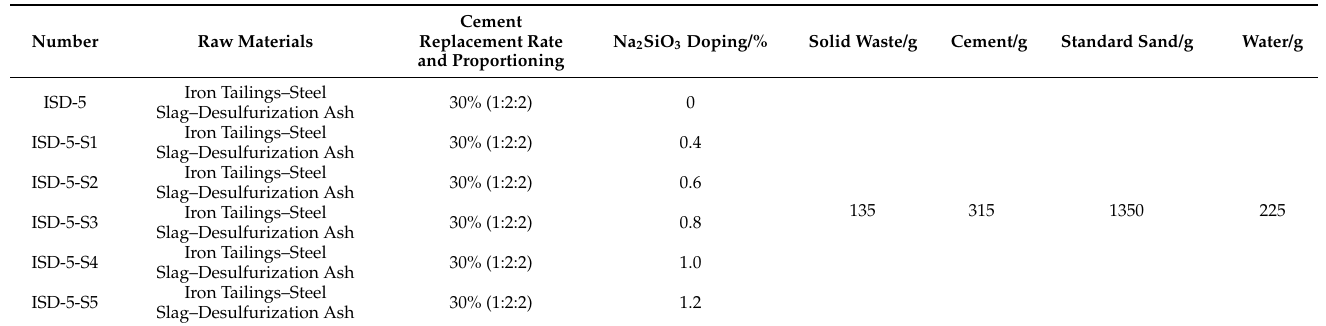
Table 3. Experimental study on the effect of variation of activator Na 2 SiO 3 doping on the mechanical properties of ISD dopant system/g.